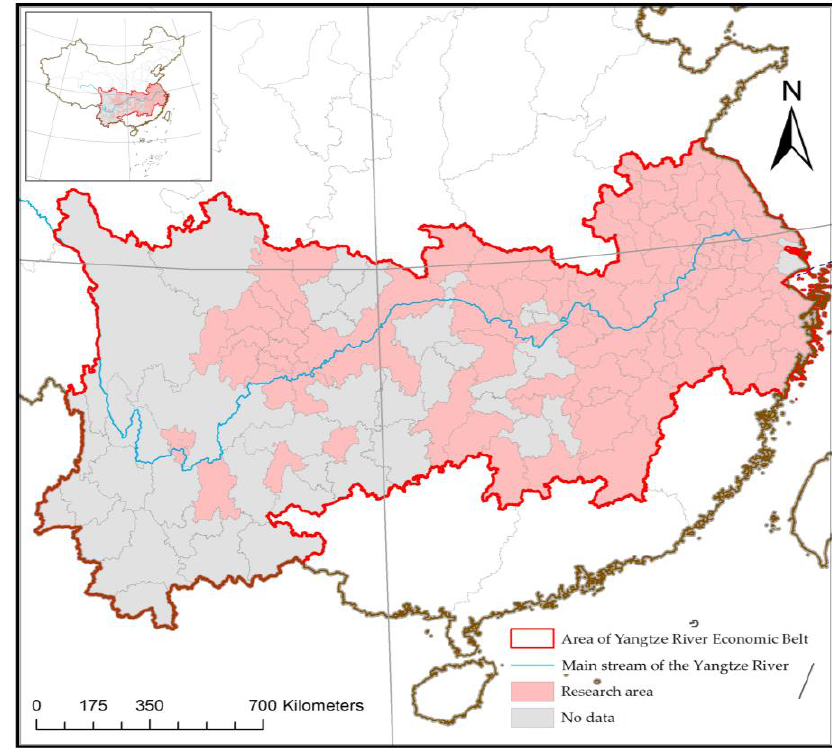
Figure 1. Research area.